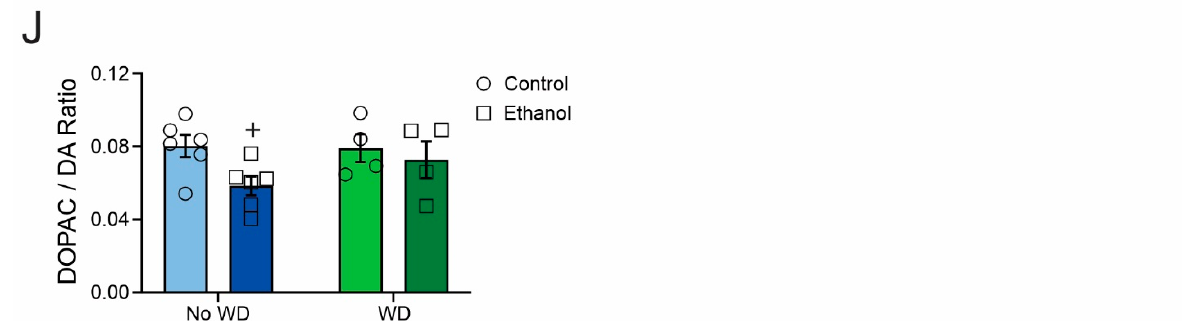
Figure 3. Two-bottle choice ethanol consumption did not significantly alter maximal dopamine release. One day of ethanol consumption ( A , B ) did not alter maximal dopamine release or dopamine transient decay rate ( C ). Four weeks of two-bottle choice drinking resulted in a trend towards increased maximal dopamine release ( D , E ) but no difference in dopamine transient decay rate ( F ). In the WD group, neither dopamine release ( G , H ) nor dopamine transient decay rate ( I ) differed from their respective controls. The DOPAC/DA ratio ( J ) trended towards a decrease in the ethanol No WD group compared to all the other groups. Number of slices indicated in parentheses from 8–10 mice per treatment group for FSCV experiments. n = 4–6 mice per group for DOPAC/DA ratios. + p < 0.10.